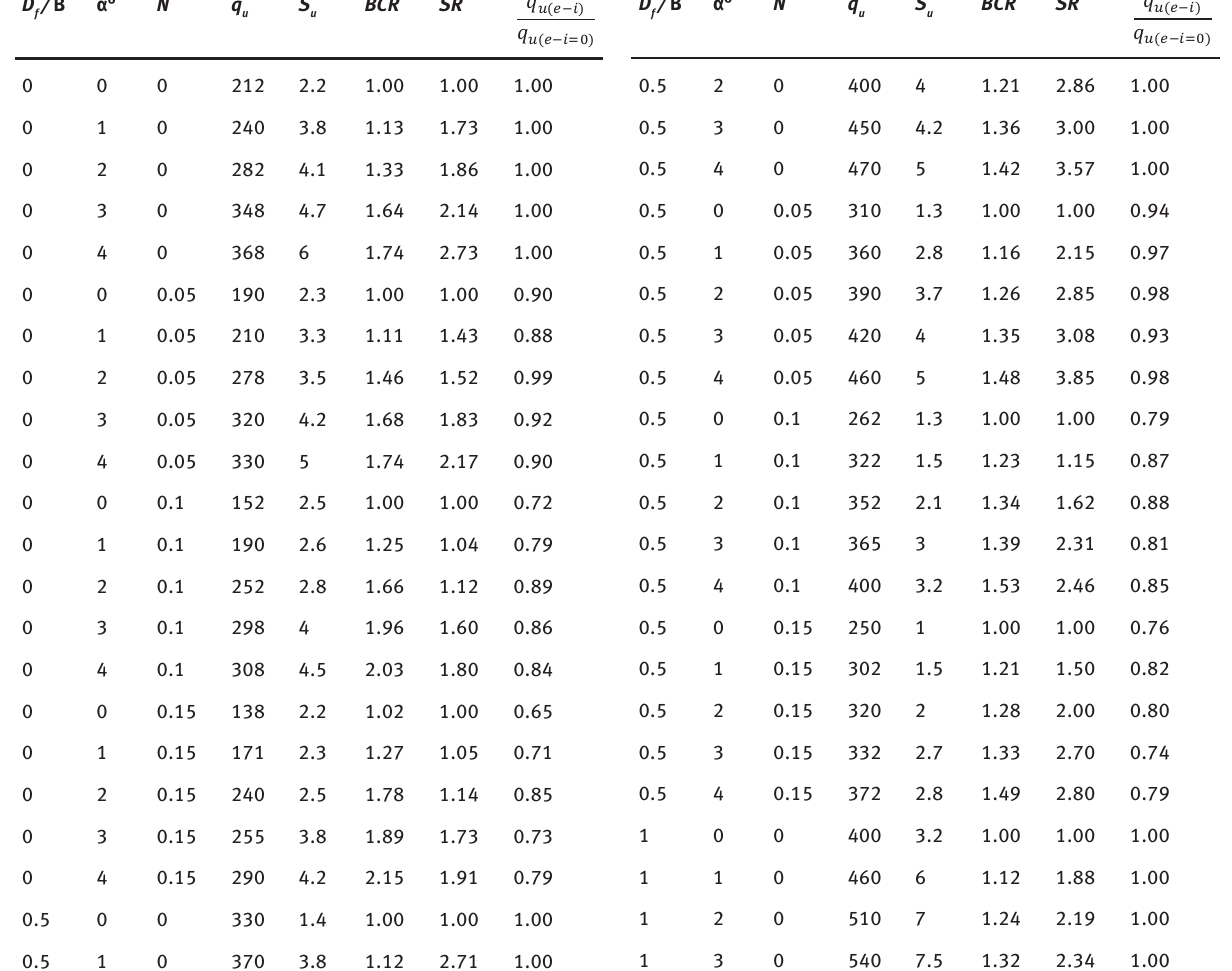
Table 2: Results of eccentrically loaded ( e/L ) rectangular footing in unreinforced and reinforced sand